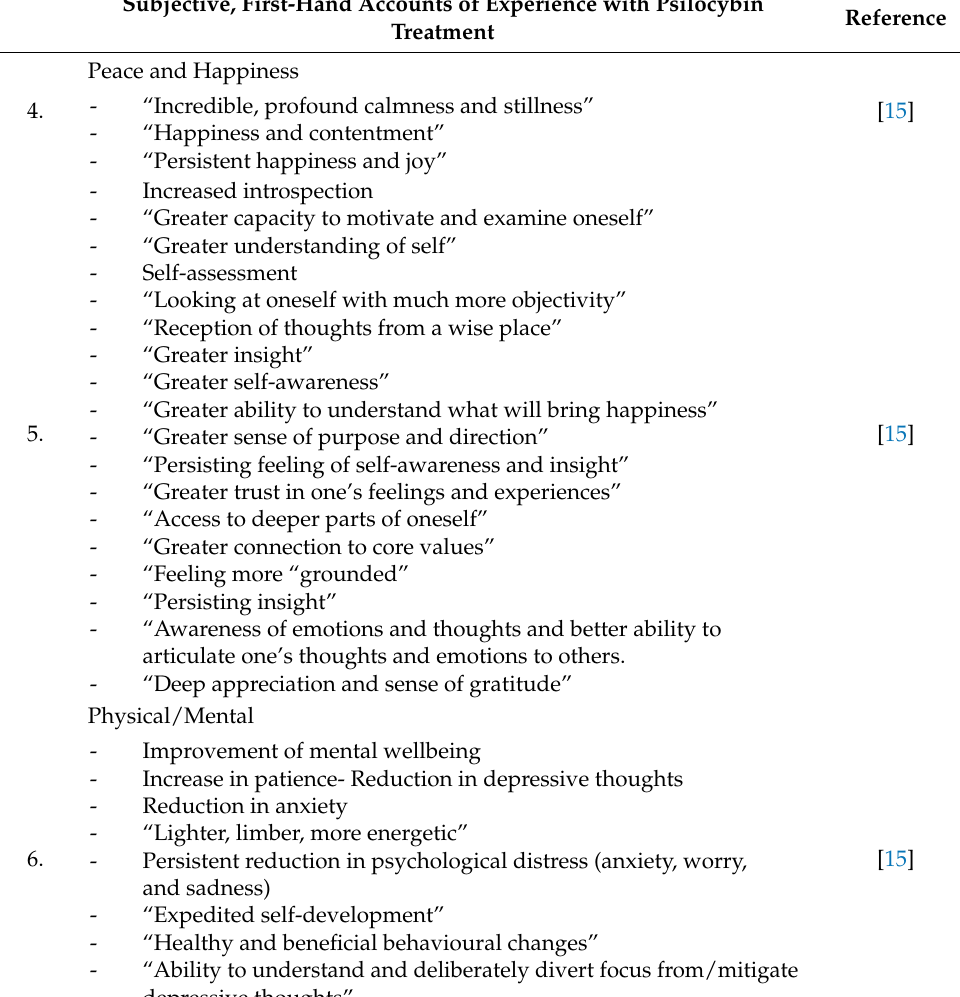
Table 5. Cont. Subjective, First-Hand Accounts of Experience with Psilocybin Treatment